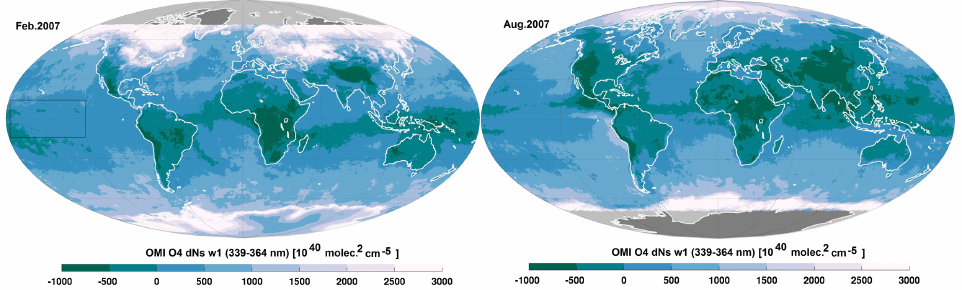
Figure 3. Monthly averaged O 2 –O 2 (O 4 ) differential slant columns retrieved in the interval 339–364nm. The slant columns are differential since radiance spectra over the equatorial Pacific region (delimited by the black box) are used as reference